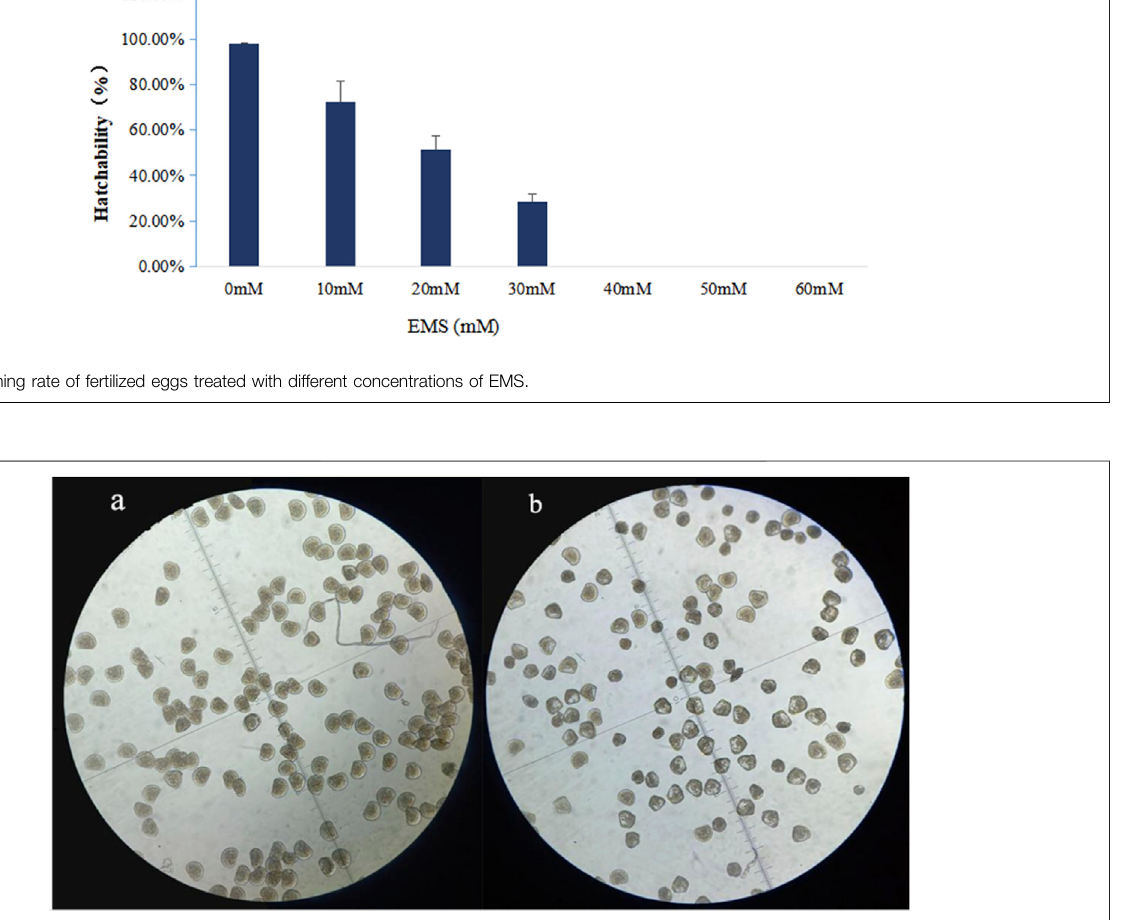
FIGURE 2 | D-formed larvae at 28 h after fertilization in the control (A) and the EMS treatment group (B)